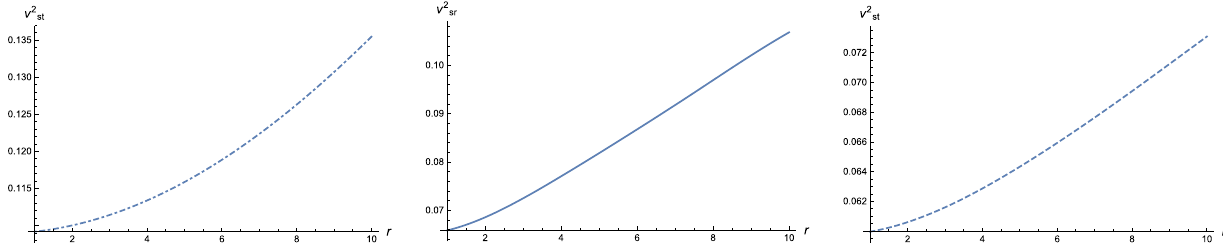
Fig. 9 Variations of v 2 r (km) of the strange star candidate Her X-1, SAX J 1808.4-3658, and 4U 1820-30; represented by st with respect radius (left to right) the first, second, and third graphs, respectively